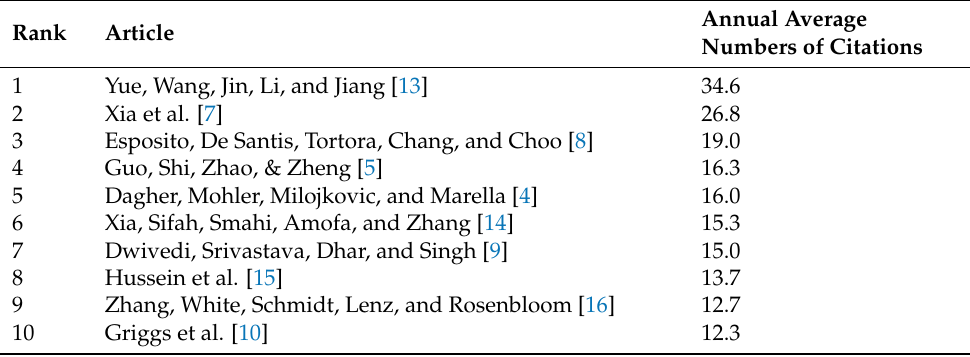
Table 1. Top ten articles in terms of the annual average numbers of